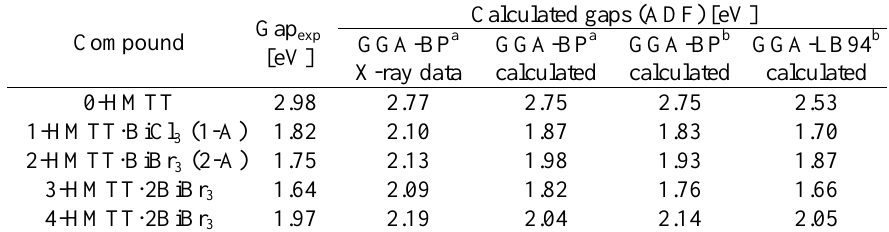
Table 2. Band gap calculated energies at DFT molecular